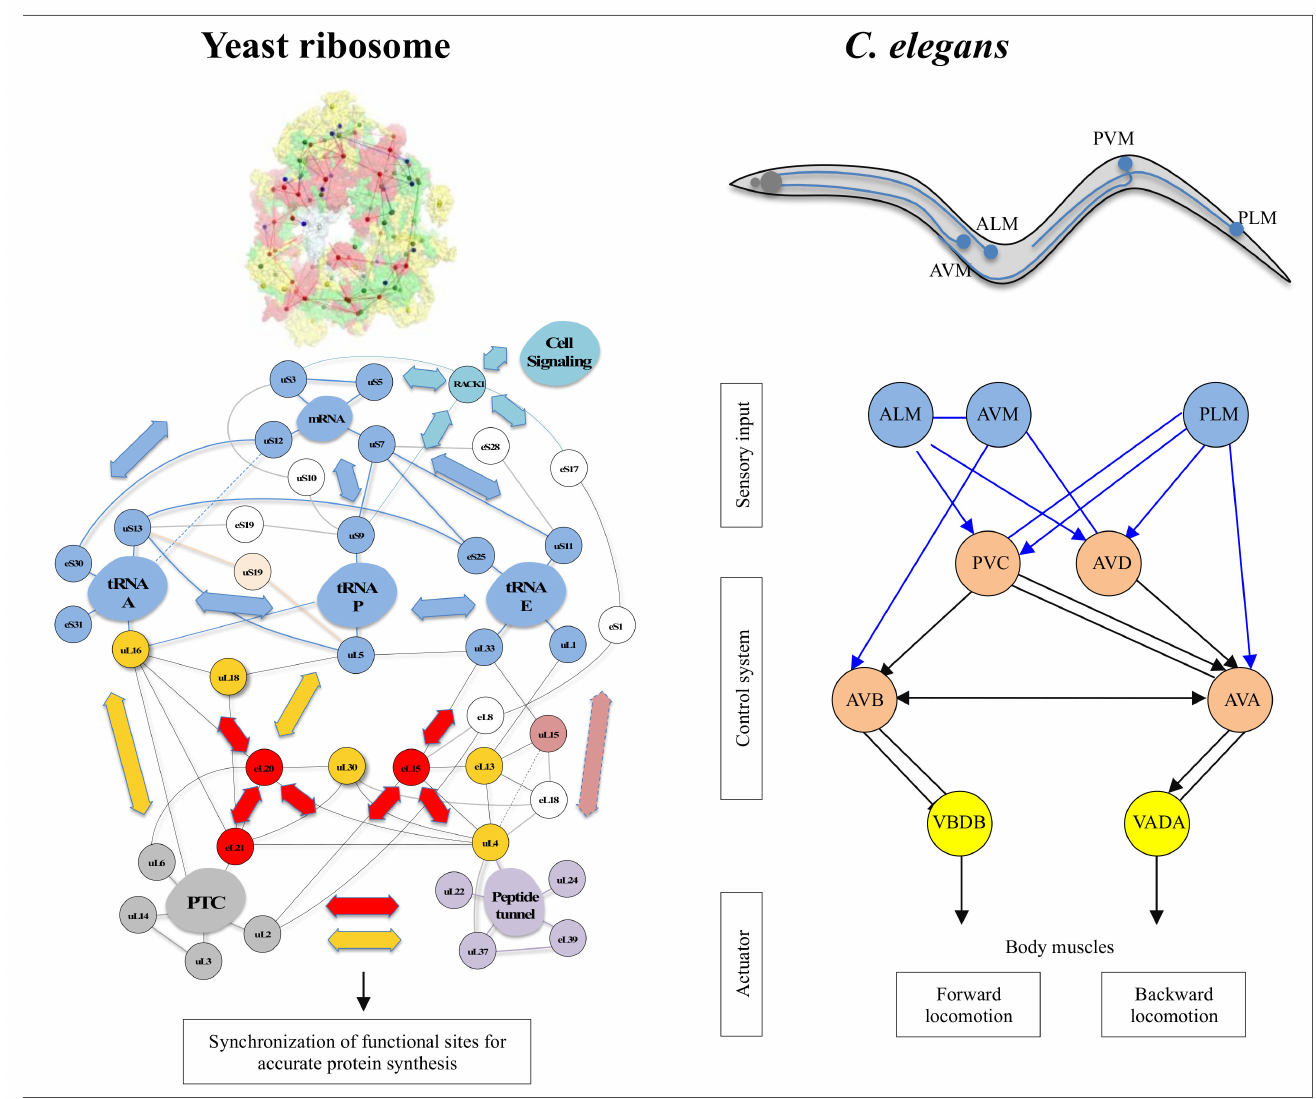
Figure 7. Functional analogy and modular organisation of the nodes in a ribosomal network (eukaryotic) and in a subnetwork of the nervous system of a simple organism ( C. elegans , adapted from ref